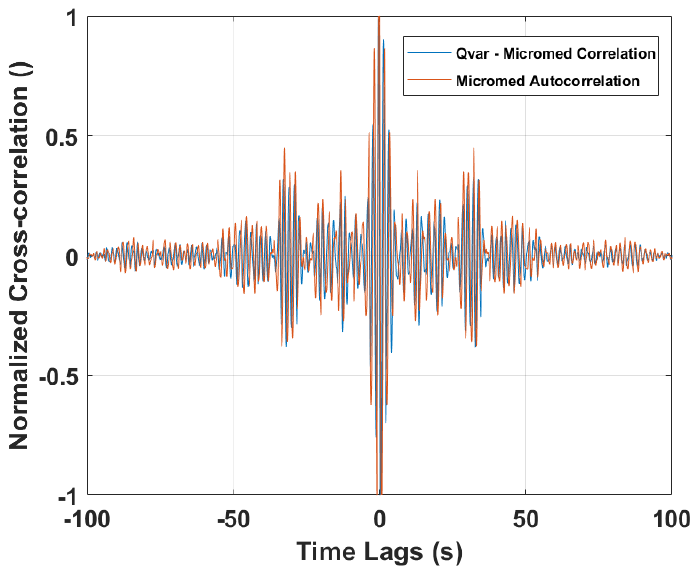
Figure 16. Cross-correlation between ST−Qvar and MicroMed acquisitions. MicroMed signal auto-correlation.